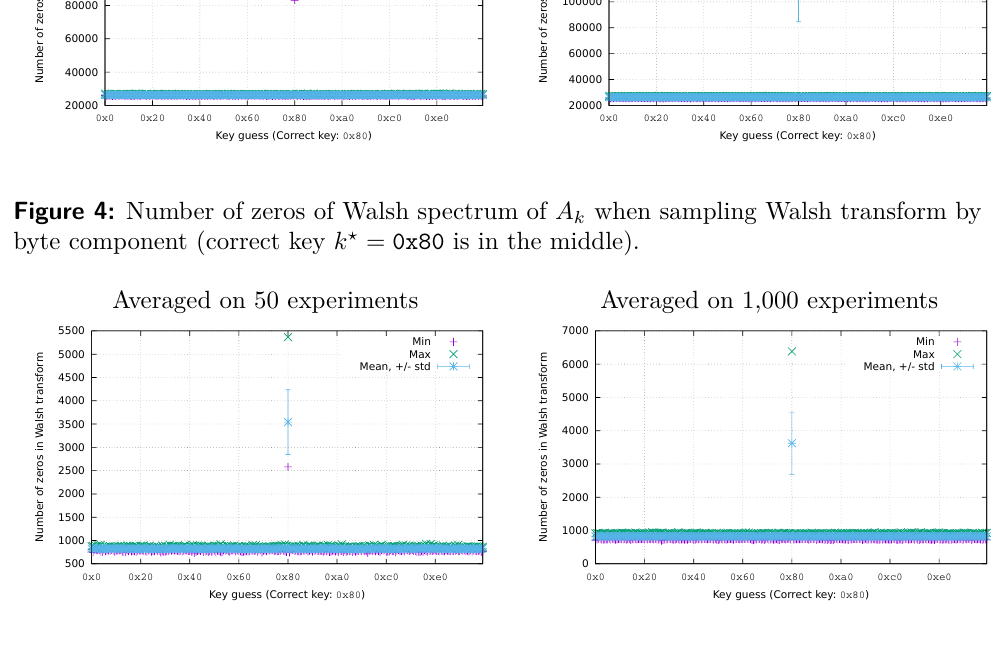
Figure 5: Number of zeros of Walsh spectrum of A k when sampling Walsh transform by coordinates (correct key k ? = 0x80 is in the